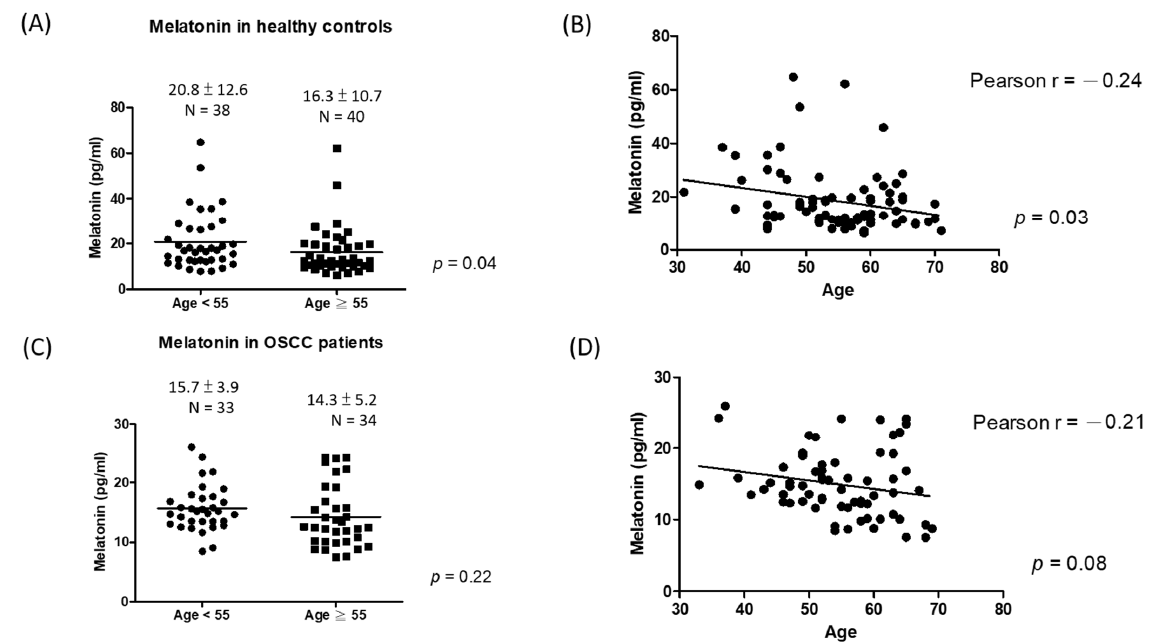
Figure 2. The correlation between age and melatonin levels in healthy controls and OSCC patients. ( A ) Melatonin levels in health controls stratified by the age of 55 years old; ( B ) the correlation between melatonin and age in healthy controls; ( C ) melatonin levels in OSCC patients stratified by the age of 55 years; ( D ) the correlation between melatonin and age in OSCC patients. OSCC